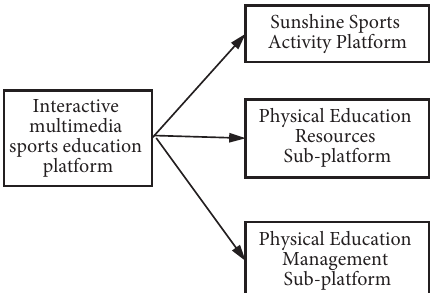
Figure 3: Overall architecture diagram of college sports infor- mation teaching platform.